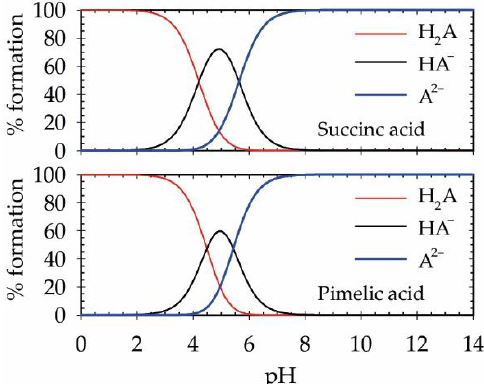
Figure 1. Speciation AH 2 , AH − , and A 2 − of succinic acid ( top ) and of pimelic acid ( bottom ) as a function of the pH value, prepared with data of [30].